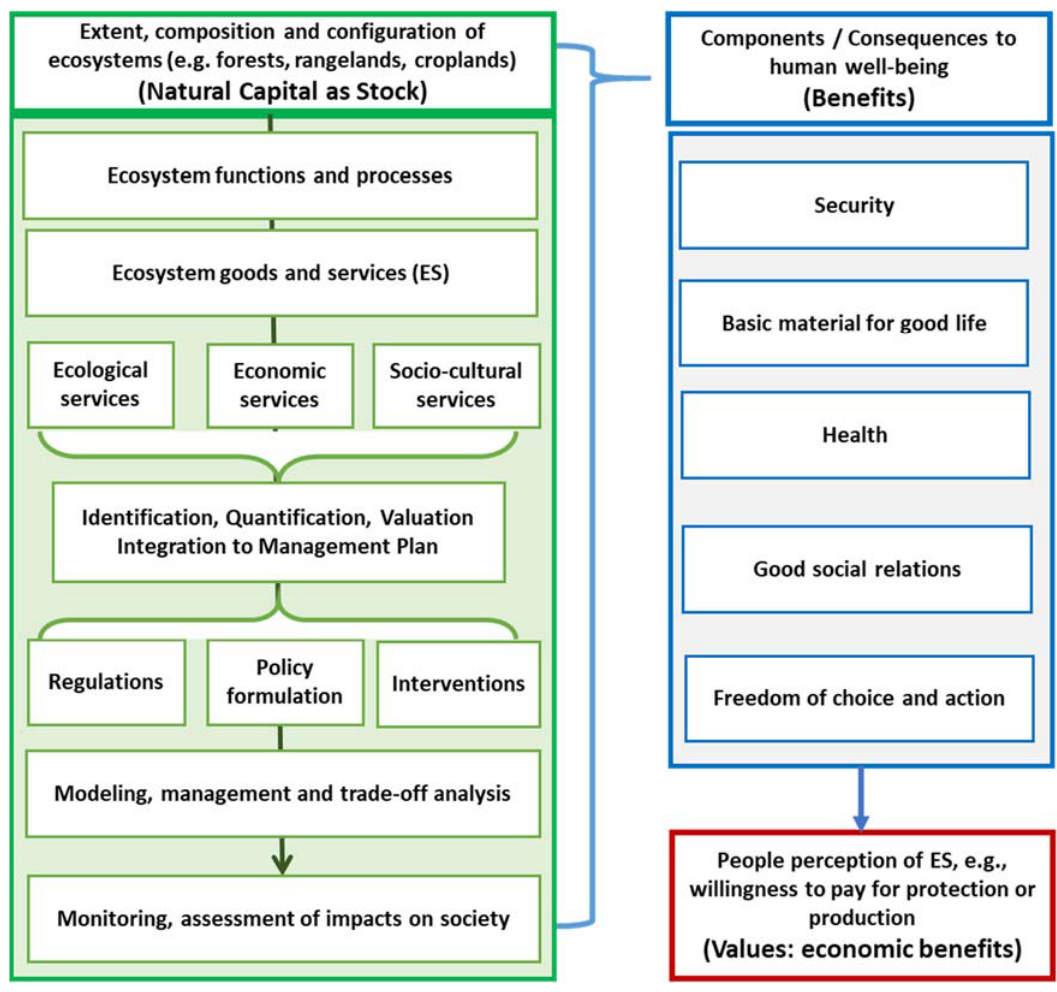
Figure 1. The framework of the concept of managing ecosystem services for the wellbeing of society.